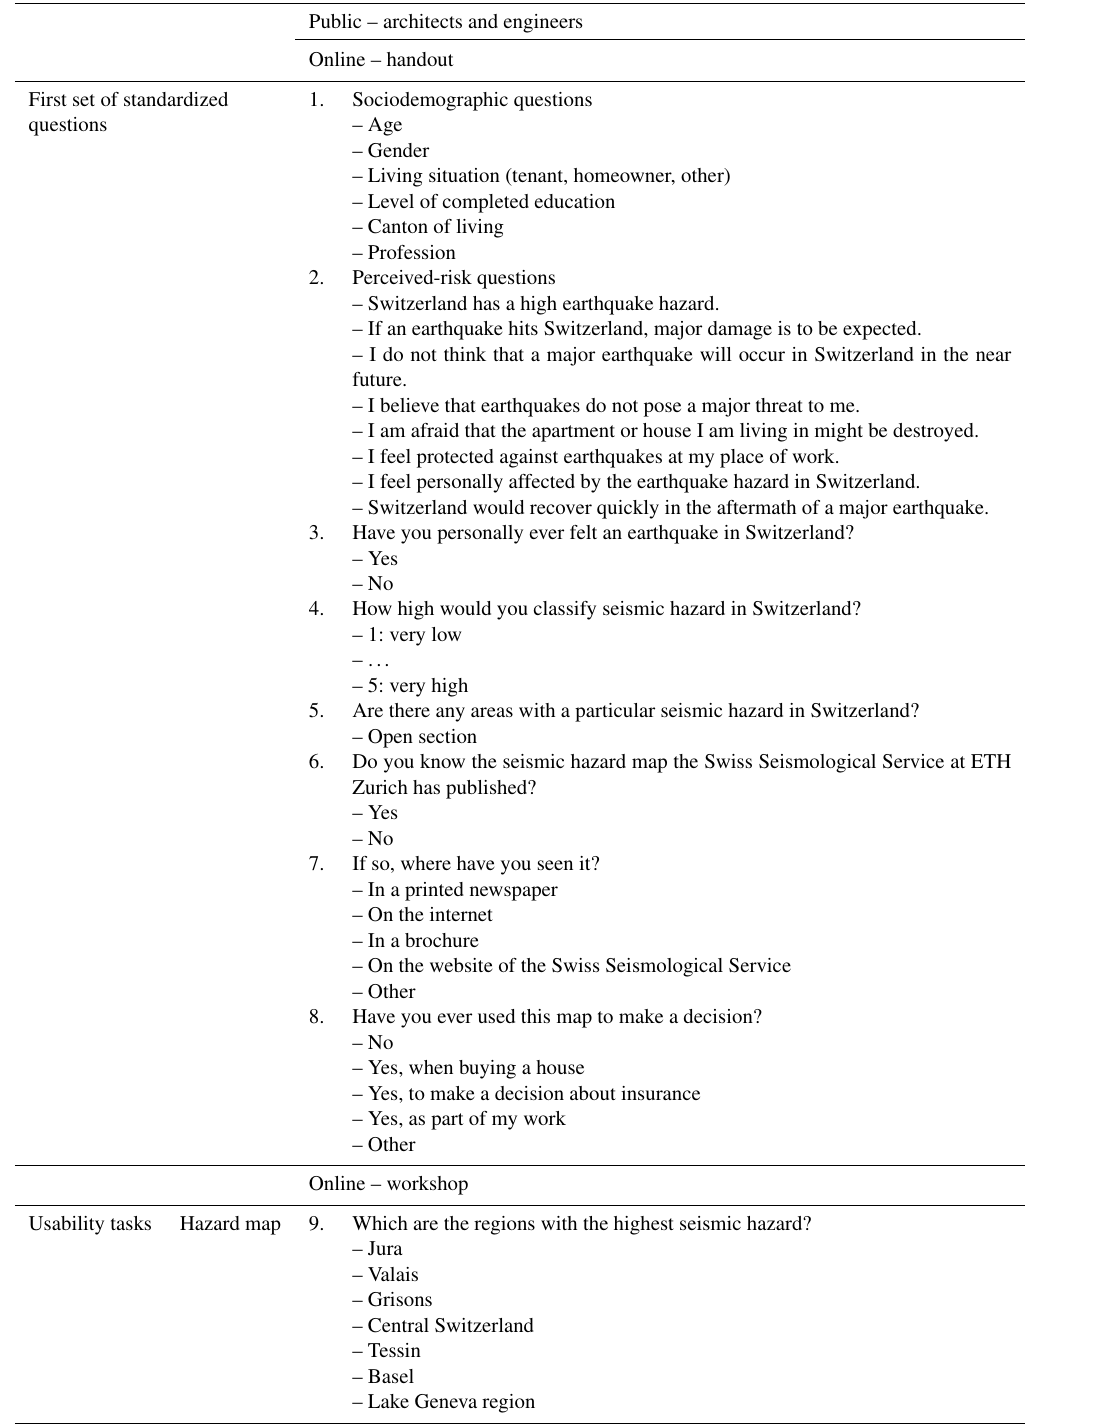
Table A1. Detailed response options and